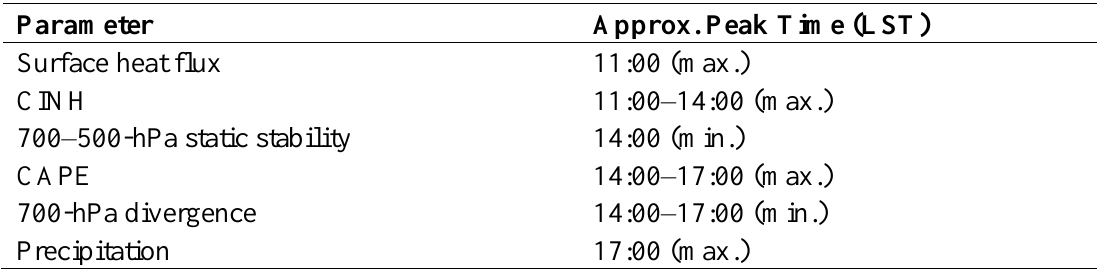
Table 1. Approximate peak time of selected precipitation-related parameters as shown in Figure